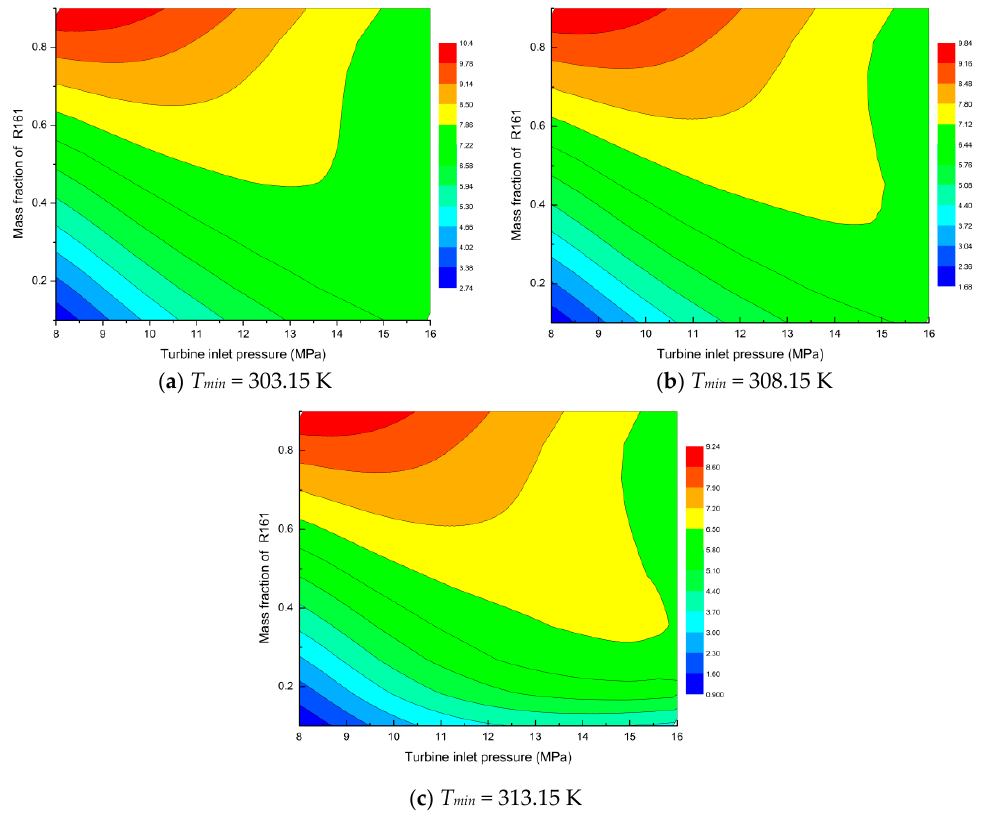
Figure 9. Contours of thermal efficiency with variation of mass fraction and turbine inlet pressure at different circulation minimum temperatures.